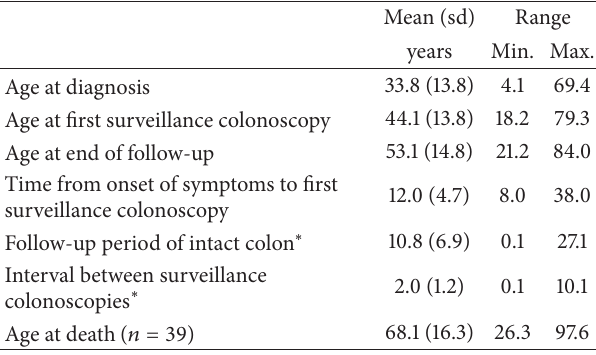
Table 1: Characteristics of the patient population (𝑛 = 293)